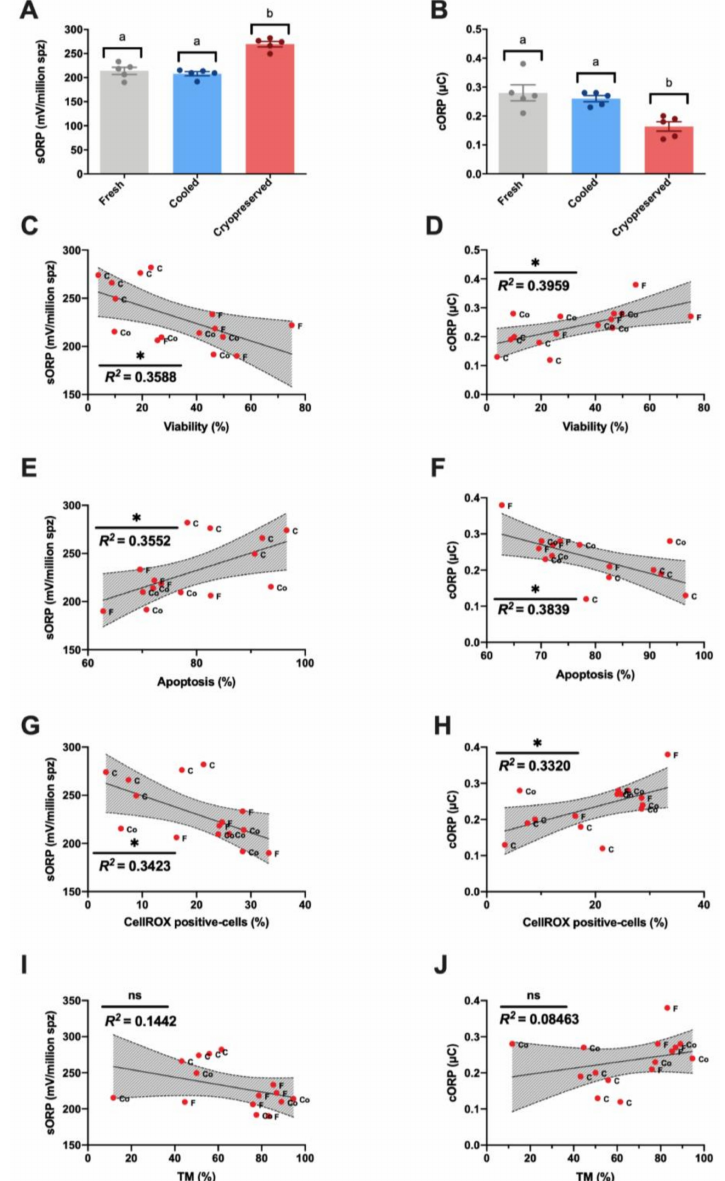
Figure 3. Ram sperm RedoxSYS analyses in the three experimental groups (fresh, cooled, and cryopreserved samples). ( A ) Static ORP (sORP) index (mV / 10 6 sperm); ( B ) capacitance ORP (cORP) index ( µ C / 10 6 sperm); ( C , D ) Correlation between sORP or cORP and viability (%); ( E , F ) correlation between sORP or cORP and apoptosis (%); ( G , H ) correlation between sORP or cORP and CellROX-positive cells (%); ( I , J ) Correlation between sORP or cORP and total motility (TM, %). The same five-eight males were analyzed in each experimental group. In the RedoxSYS analysis, significant di ff erences ( p < 0.05) are represented with di ff erent letters. In correlation studies, the R squared value is included in each graph, a significant correlation is represented by a di ff erent number of asterisks. The number of asterisks (*) indicates the significance levels: one asterisk (*) indicates p < 0.05 and ns indicates non-significant di ff erences. All correlations are included in the correlation matrix (Appendix A, Figure A2). Red dots represent all males (five–eight). Each dot is identified by a label with its experimental group (F-fresh, Co-cooled and C- cryopreserved